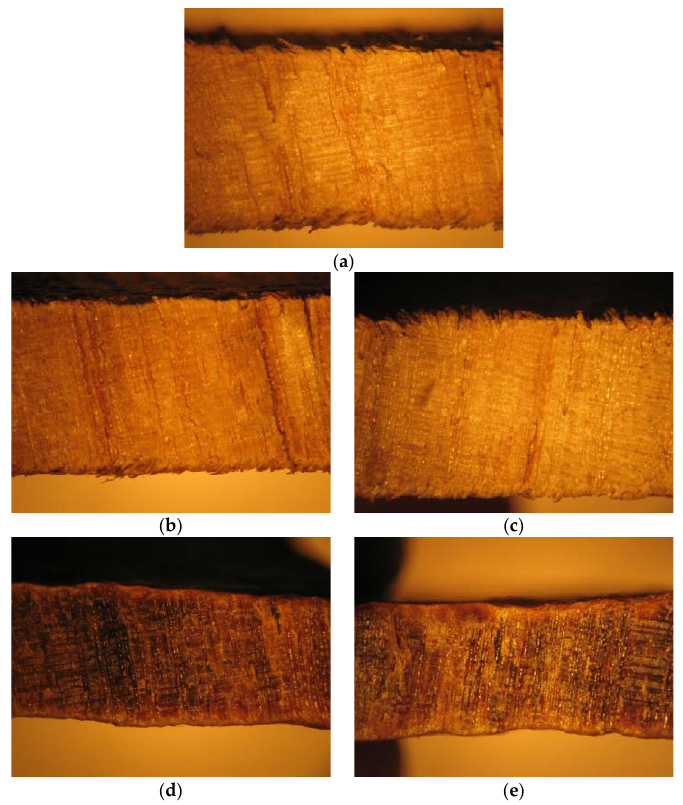
Figure 16. Fracture cross-section of the standard oak sample ( a ) and the samples immersed in 5% NaClO and 100% NaClO for three weeks ( b , d ) and three months ( c , e), From the images, it is possible to observe in detail the rupture zone of the samples, where a distinct fracture aspect among the three samples is visible. The fracture of the sample immersed in 5% NaClO is similar to the standard one, but in the sample immersed in 100% NaClO, it is possible to observe the aspect of intense degradation suffered by the material, alongside a decrease in its cross-section. The elongation of the immersed samples is caused by the enlargement of the pores of the material, also degrading the structure that resists the material, letting it elongate further. The internal structure of the oak remains like the structure of the standard sample. For the images after three months, there is clearly a more advanced state of degradation. Unlike the beech, which under these conditions presented a difference in colouring on the sample’s surface, indicating its deterioration, the internal structure of the oak remains like that of the standard sample. After three weeks of immersion, the results obtained from the tensile test show that there are significant differences in the behaviour of the material, namely in terms of tensile strength and elongation, as can be seen in Figure 17.